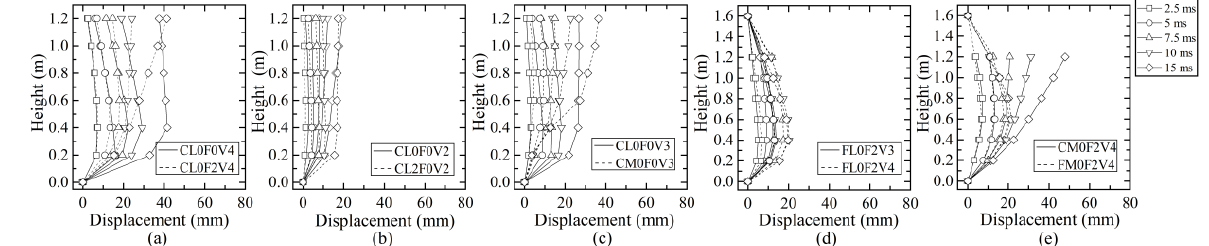
Figure 10. Parametric effect on lateral displacement distribution: ( a ) number of CFRP layers; ( b ) axial compression ratio; ( c ) impact height; ( d ) impact velocity; ( e ) boundary condition.